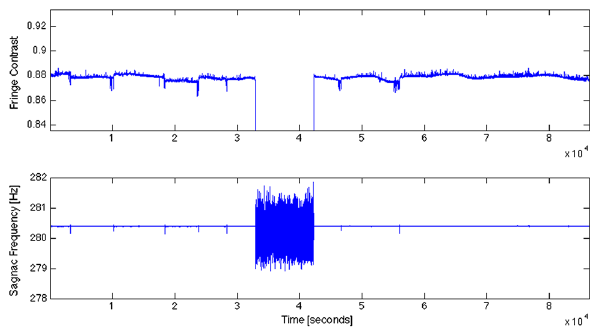
Fig. 6 Top: typical fringe contrast, the mode jumps are evident, it is also clear that instabilities occur before the mode jumps, in the middle there is a split mode operation of the duration of 2.6 h. Bottom: the corresponding Sagnac frequency